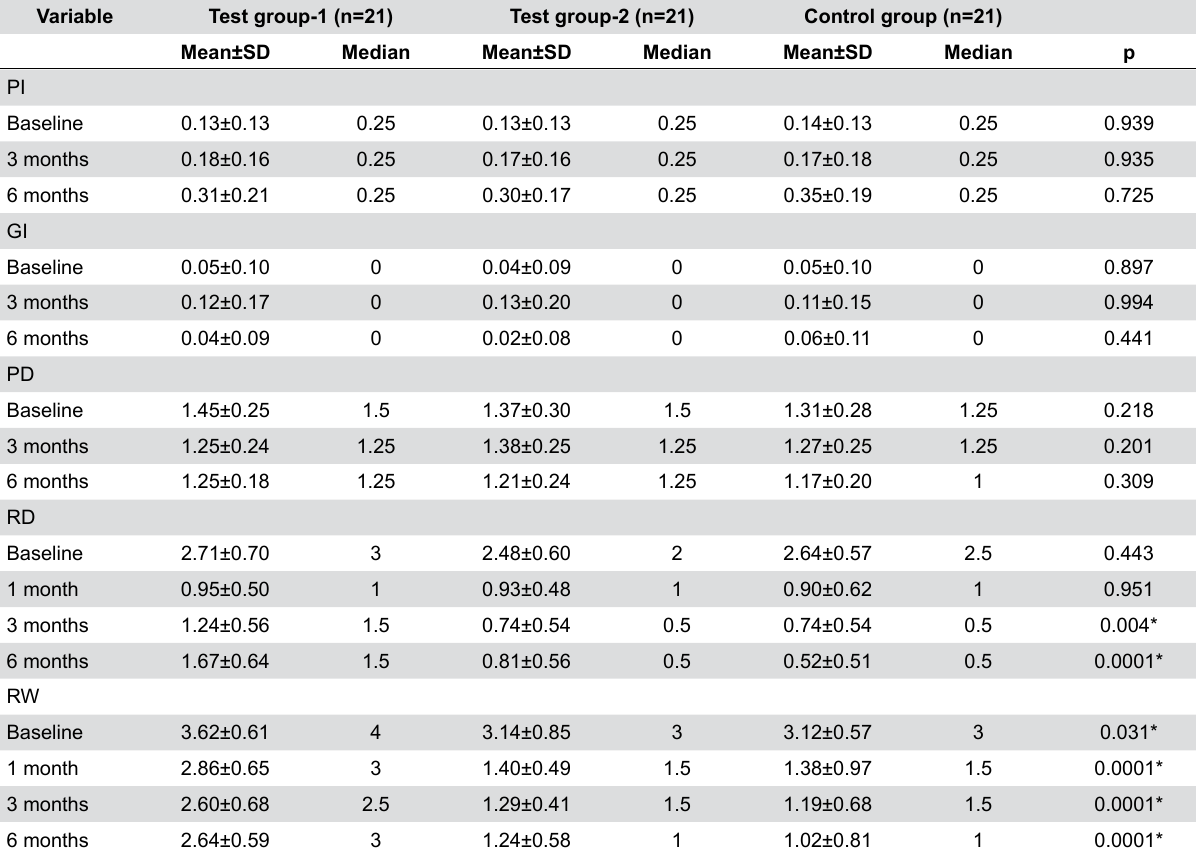
Table 1- Clinical evaluation of PI, GI, PD, RD,